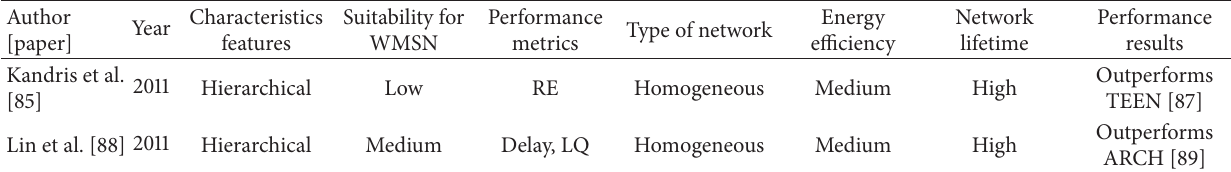
Table 6: Hierarchical routing protocols.